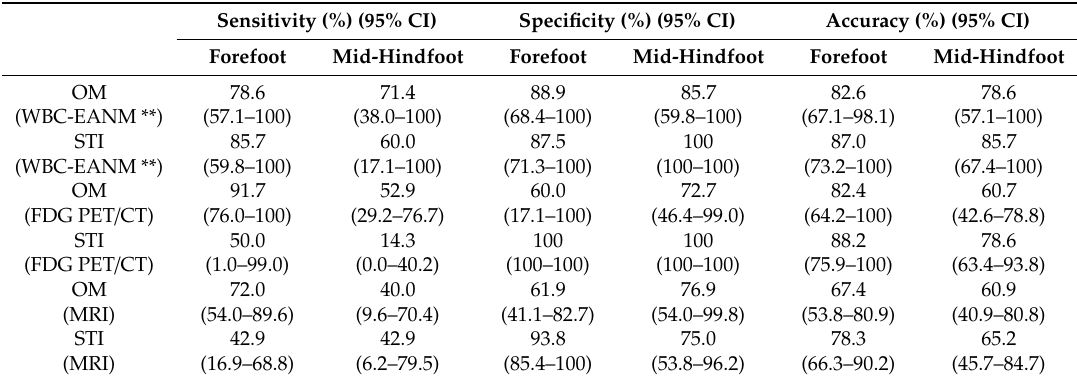
Table 5. Comparison between the performance of WBC scintigraphy, FDG PET / CT, and MRI in detecting OM and STI according to the location.